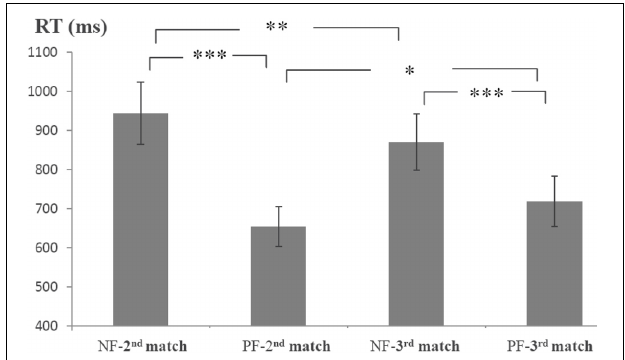
FIGURE 2 | Average reaction times (RTs) for the 2nd and 3rd matches preceded by different feedback. NF-2nd match denotes the second match preceded by a negative feedback, and PF-2nd match denotes the second match preceded by a positive feedback. NF-3rd match denotes the third match preceded by a negative feedback, and PF-3rd match denotes the third match preceded by a positive feedback. Error bars refer to standard error of the mean. ∗∗∗ p < 0.001; ∗∗ p < 0.01; ∗ p < 0.05.